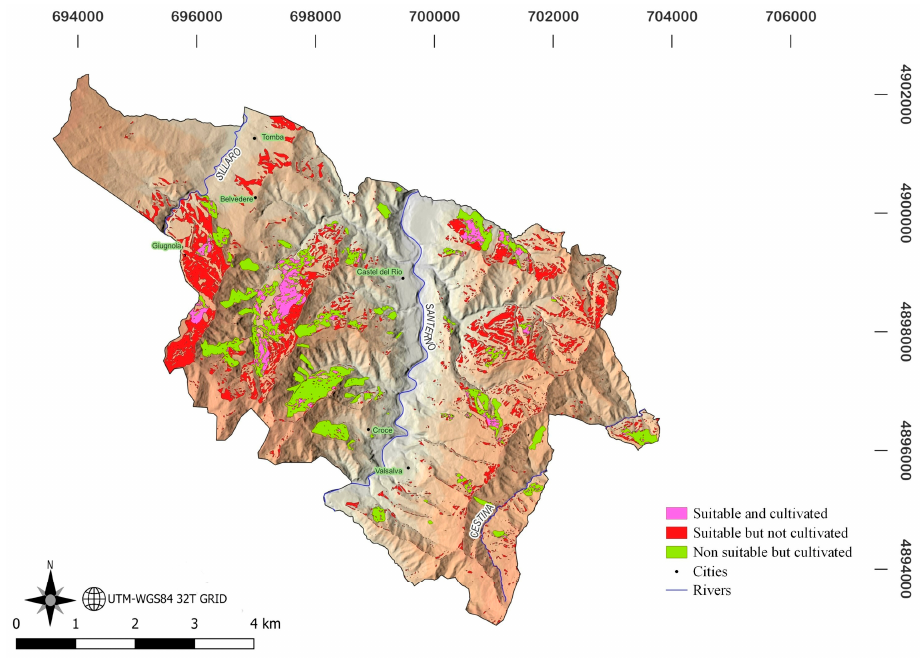
Figure 7. Map of Castel del Rio, Emilia-Romagna Region (Italy), showing the suitable areas for the cultivation of chestnut stands for fruit production (CSFP) and currently used for CSFP, the suitable areas for the cultivation of the CSFP but currently not used for CSFP, and the overlapping of suitable and cultivated CSFP areas.